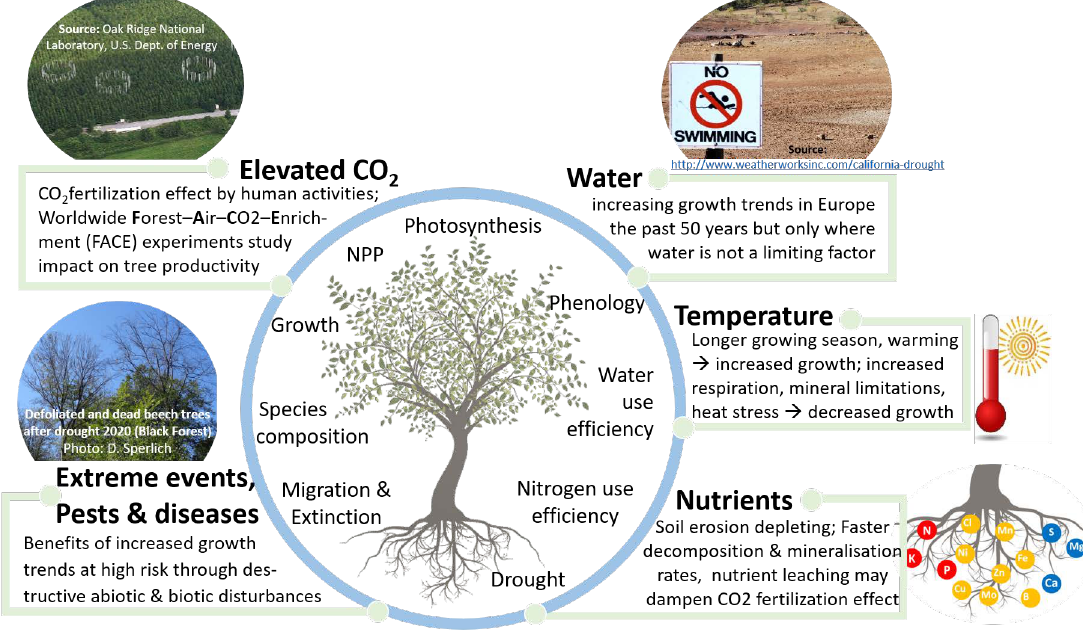
Figure 1. Summary of major ecological and ecophysiological factors associated with climate change and their impacts on various biological processes in trees (modified after